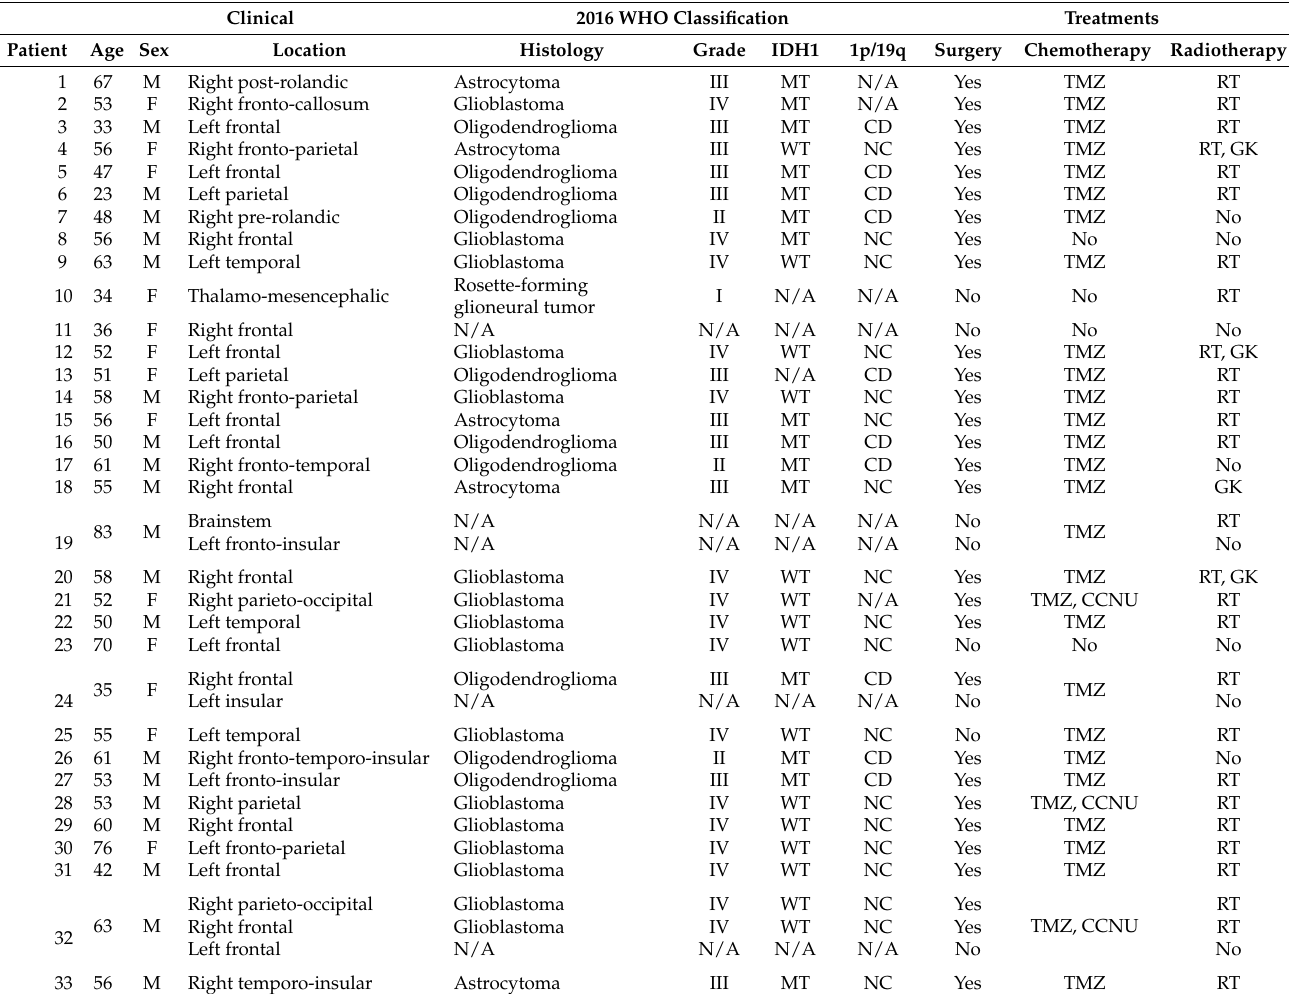
Table A1. Patient’s clinical data, location and 2016 WHO classification of each analyzed lesion, and undergone treatments at imaging time. F: female, M: male, N/A: not available, MT: mutant, WT: wildtype, CD: codeleted, NC: non-codeleted, TMZ: temozolomide, CCNU: lomustin, RT: conventional radiotherapy, GK: gamma knife. Multiple lesions were identified for patients 19, 24, and 32. Patients 1 to 20 and 21 to 33, respectively, belong to the PCA model-building and evaluation